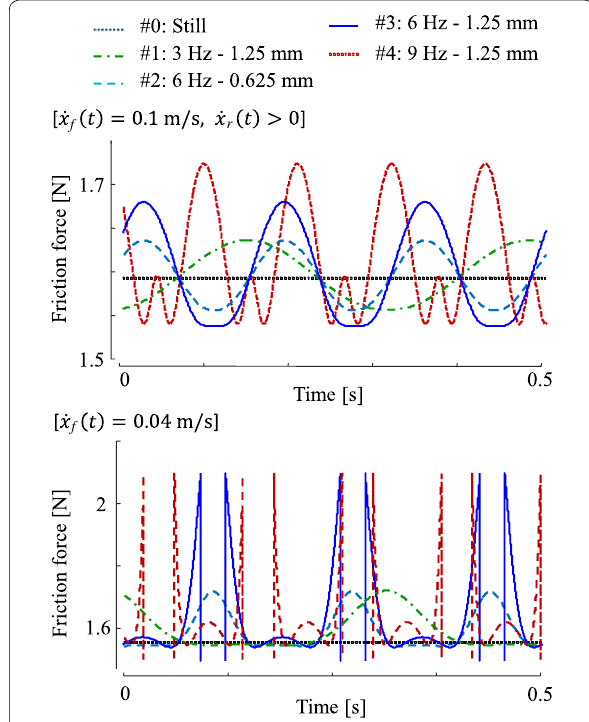
Fig. 7 Temporal course of simulated friction forces caused by vibrotactile stimuli. Top When ˙ x f = 0.1 m/s and ˙ x r ( t ) > 0 constantly apply. Bottom When ˙ x f = 0.04 m/s and ˙ x r ( t ) can be zero. For stimuli #3 and #4, the simulated friction forces are not continuous because the direction of the friction force is not always the same as that of the finger